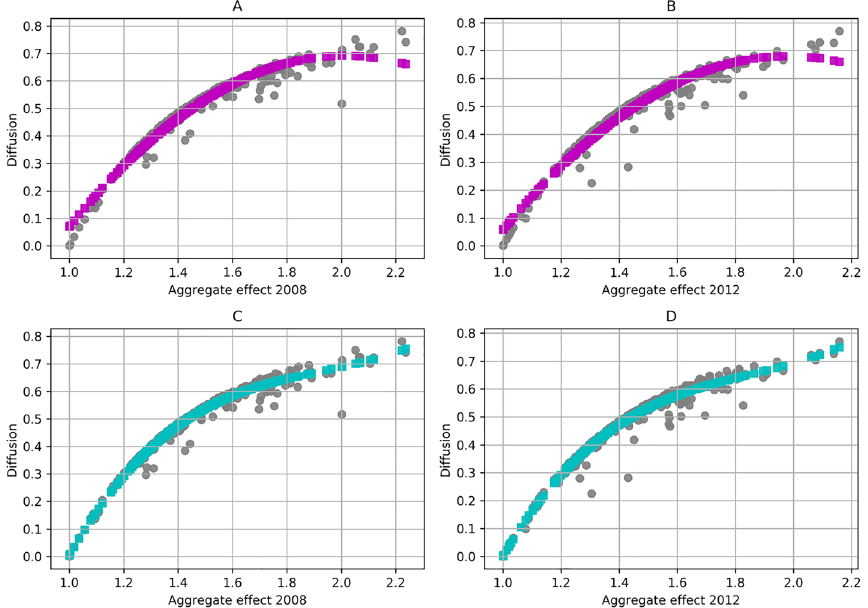
Fig. 2 Polynomial fitting of the relation between aggregate effect and diffusion. Horizontal axis is for aggregate effect and vertical axis is for diffusion. Polynomial fitting of degree 2 (first row) and of degree 3 (second row) of the relation between aggregate effect ( x ‑axis) and diffusion ( y ‑axis) for 2008 (first column) and 2012 (second column). Dots are data and squares are the fitted values. Source: Visualizations made by authors based on authors calculations using Python 3.8 and Python libraries scipy, numpy, and matplotlib